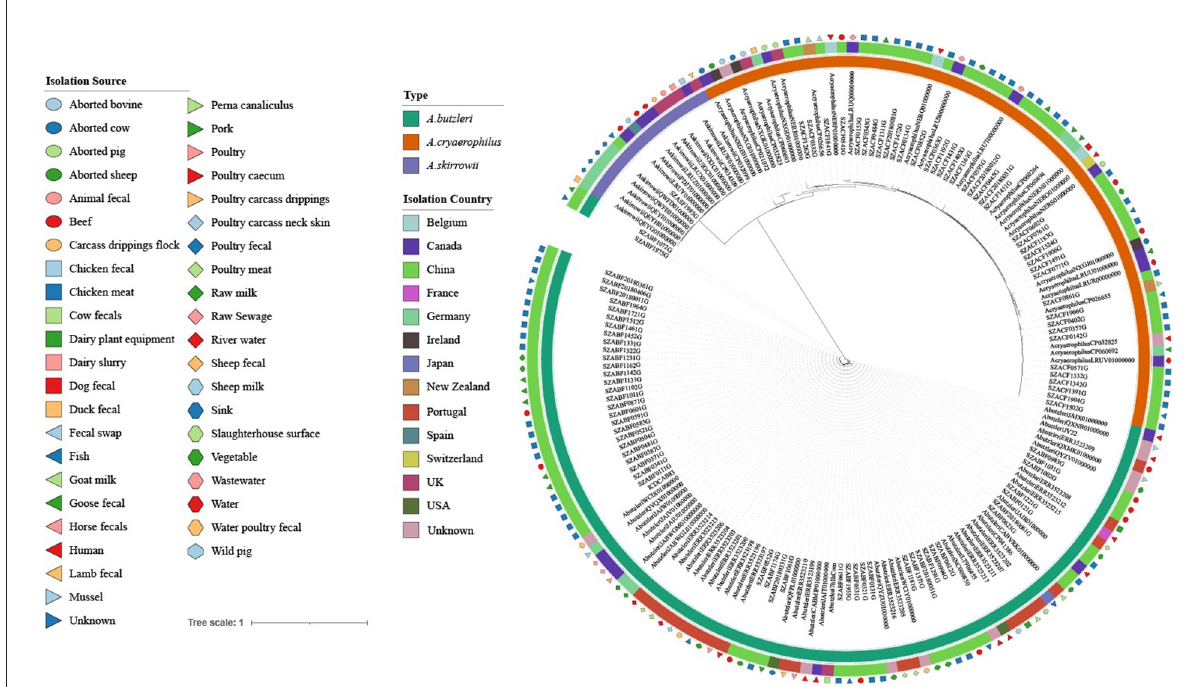
FIGURE4 Maximum likelihood (ML) tree of the core genome alignments of strains isolated from various sources and countries with 1,000 bootstraps. Different colors and shapes indicate various sources. From the inner circle to the outer circle, strains, Type, Isolation Country, and Isolation Source are